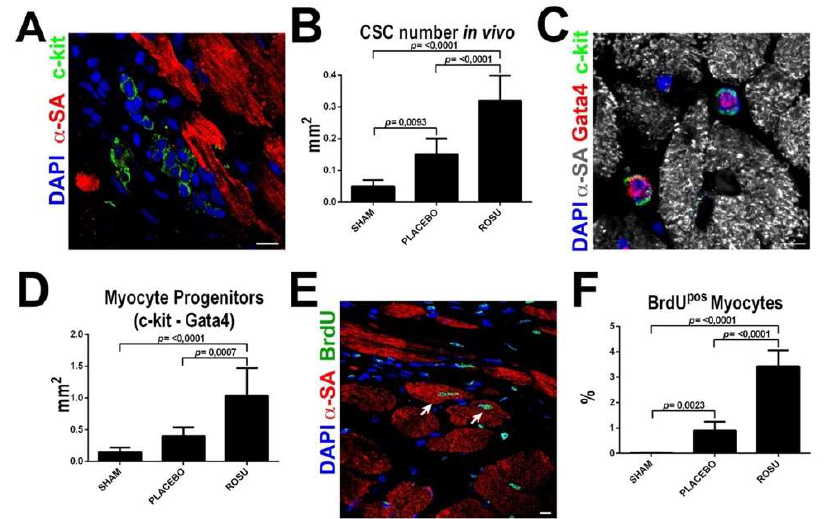
Figure 3. Statins increase CSC number and new myocyte formation after myocardial infarction in vivo. ( A , B ) Representative confocal image and bar graph show an increased number of uncom- mitted lineage negative CSCs in the border infarct zone in ROSU treated animals when compared to untreated counterparts. Scale Bar = 10 µ m ( C , D ) Representative confocal image and bar graph show an increased number of CSCs with myogenic commitment in ROSU treated animals as revealed by Gata4 expression. Scale Bar = 10 µ m ( E ) Representative confocal microscopy image of BrdU incorporation (BrdU positive, green fluorescence) in the border zone of a ROSU-treated infarcted rat heart. Scale bar 50 µ m. ( F ) Number of newly-generated BrdU pos cardiomyocytes 28 days after MI in rats untreated (placebo control, CTRL) or treated with rosuvastatin (ROSU); p < 0.05 vs. all. SHAM, n = 5; MI (placebo control), n = 5; MI+ROSU, n = 6. Adapted from Cianflone et al.